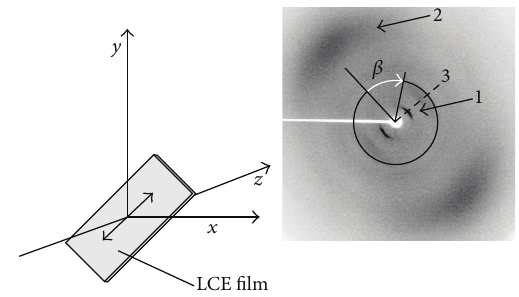
Figure 7: Sketch of the experimental setup and the X-ray diffraction pattern of the CN100 LSCE film at 𝑇 = 60 ∘ C. In the figure, the small angle diffraction peaks (arrow 1) are due to smectic clusters, and the wide angle diffraction peaks (arrow 2) are associated with order ⊥ n